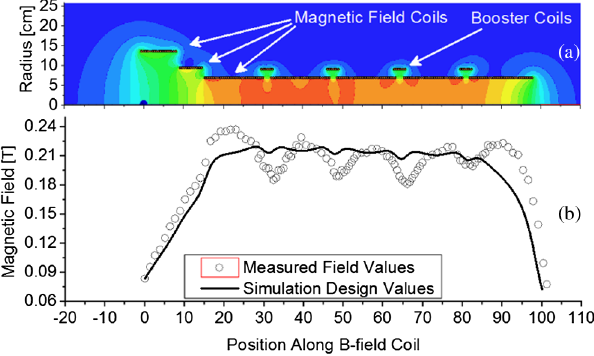
FIG. 5. Slice of the simulated coil configuration, overlaid with a pseudocolor plot of the magnetic field magnitude (a), and the magnetic field measured along the length of the drift tube at a radius of 4 cm, overlaid with the corresponding simulation values (b). Magnetic field simulations were performed using Ansys Maxwell.